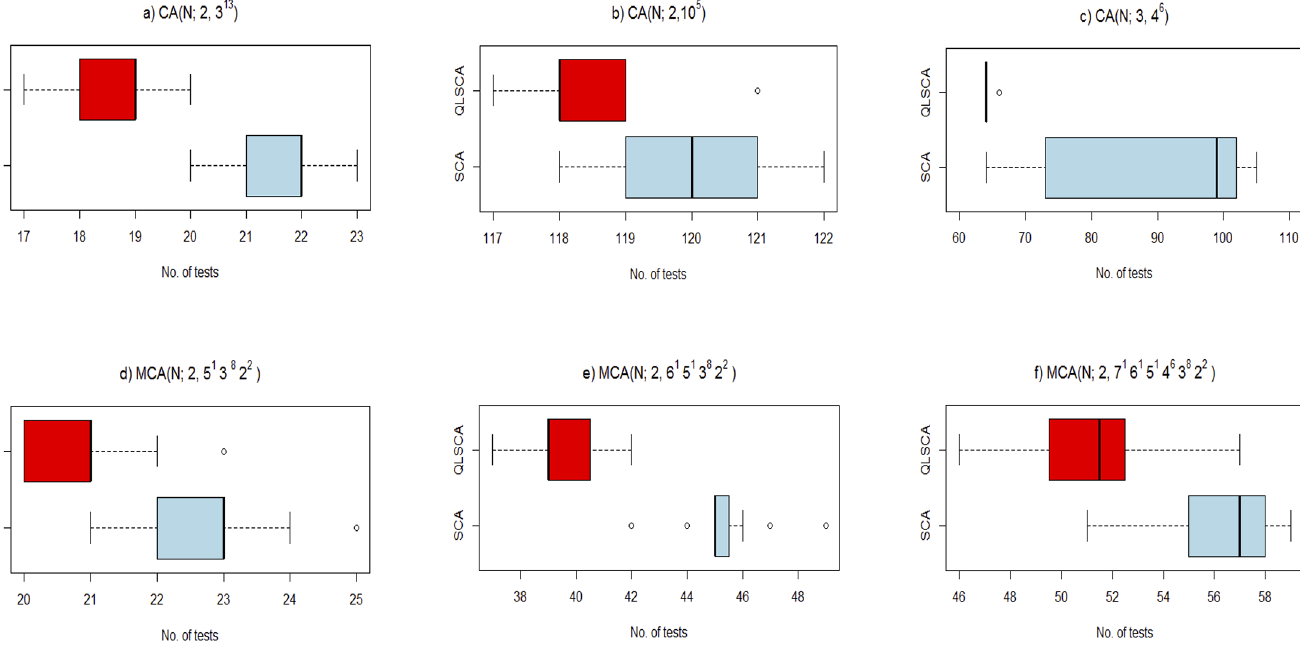
Fig 8. Box plots for Table